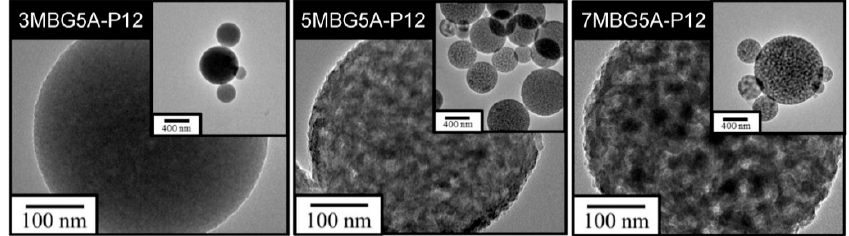
Figure 9. The FE-TEM images of MBG adding different concentrations of PEG.